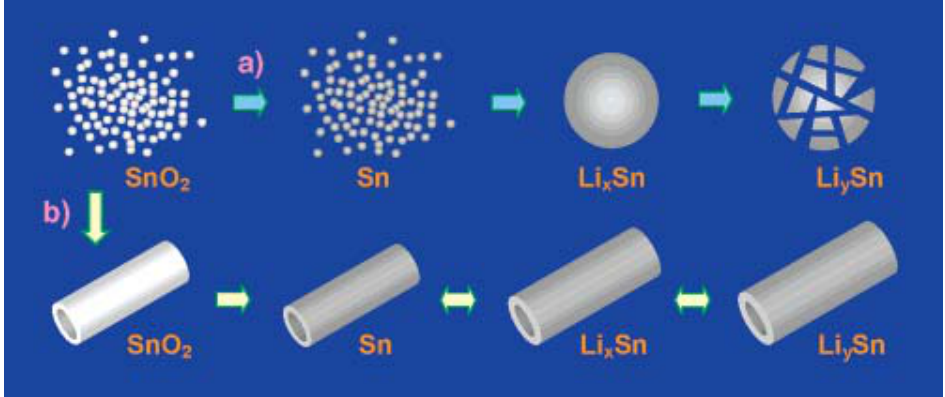
Figure 8. Schematic illustrations of two different fabrications of SnO nanoparticles without preorganization cause aggregations and pulverization of Li (assuming y,x ) upon cycling; ( b ) when nanocrystallites of SnO configuration, concentric expansion and contraction could be expected upon lithium charging and discharging. Adapted with permission from [59]. Copyright 2005 American Chemical